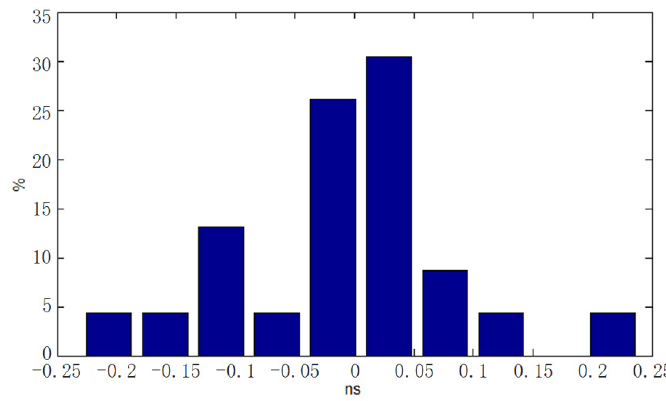
Figure 16. Histogram of difference statistics.